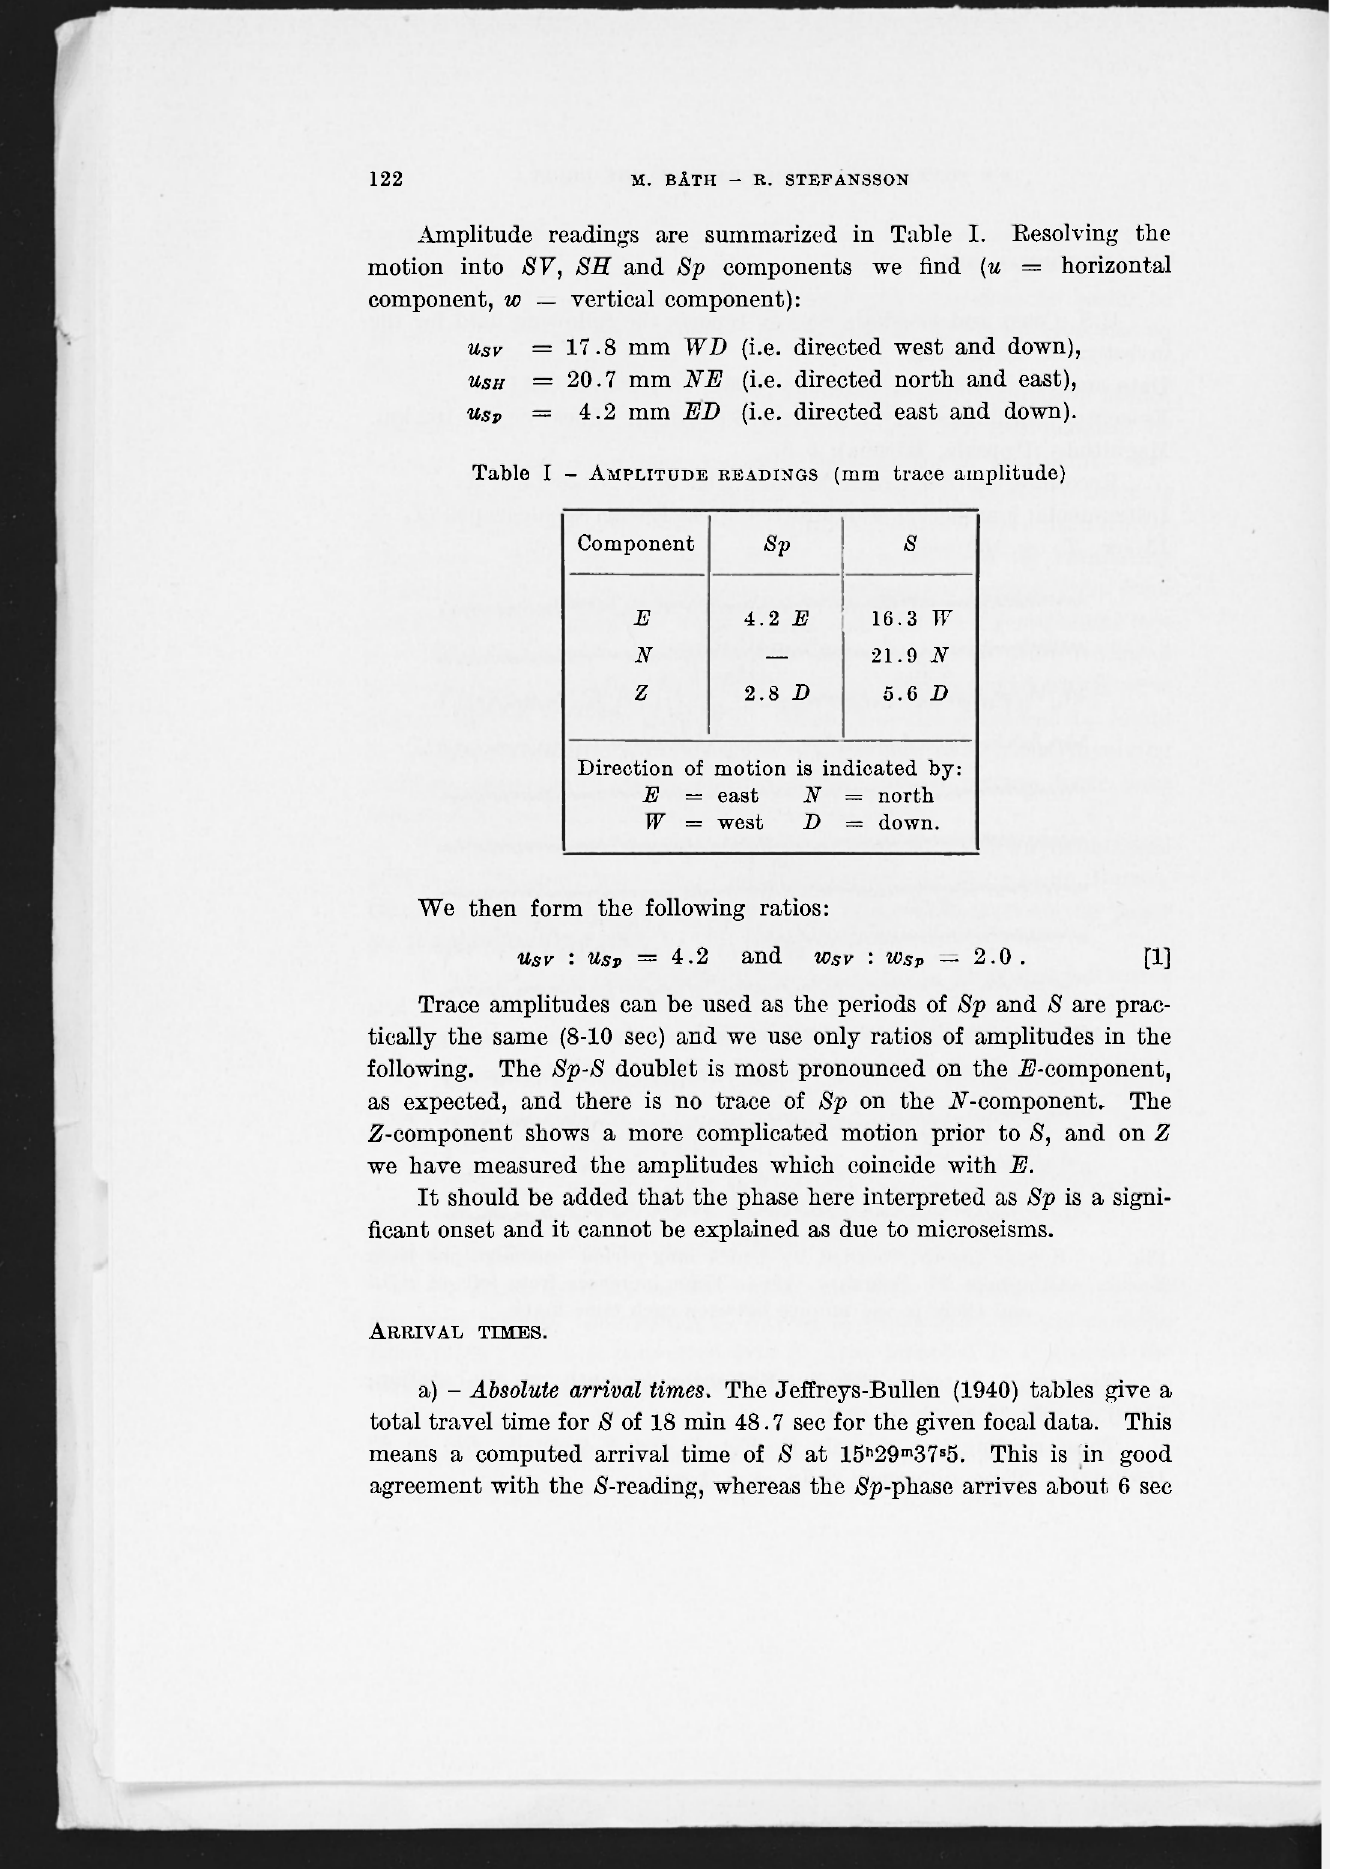
Table I - AMPLITUDE READINGS (mm trace